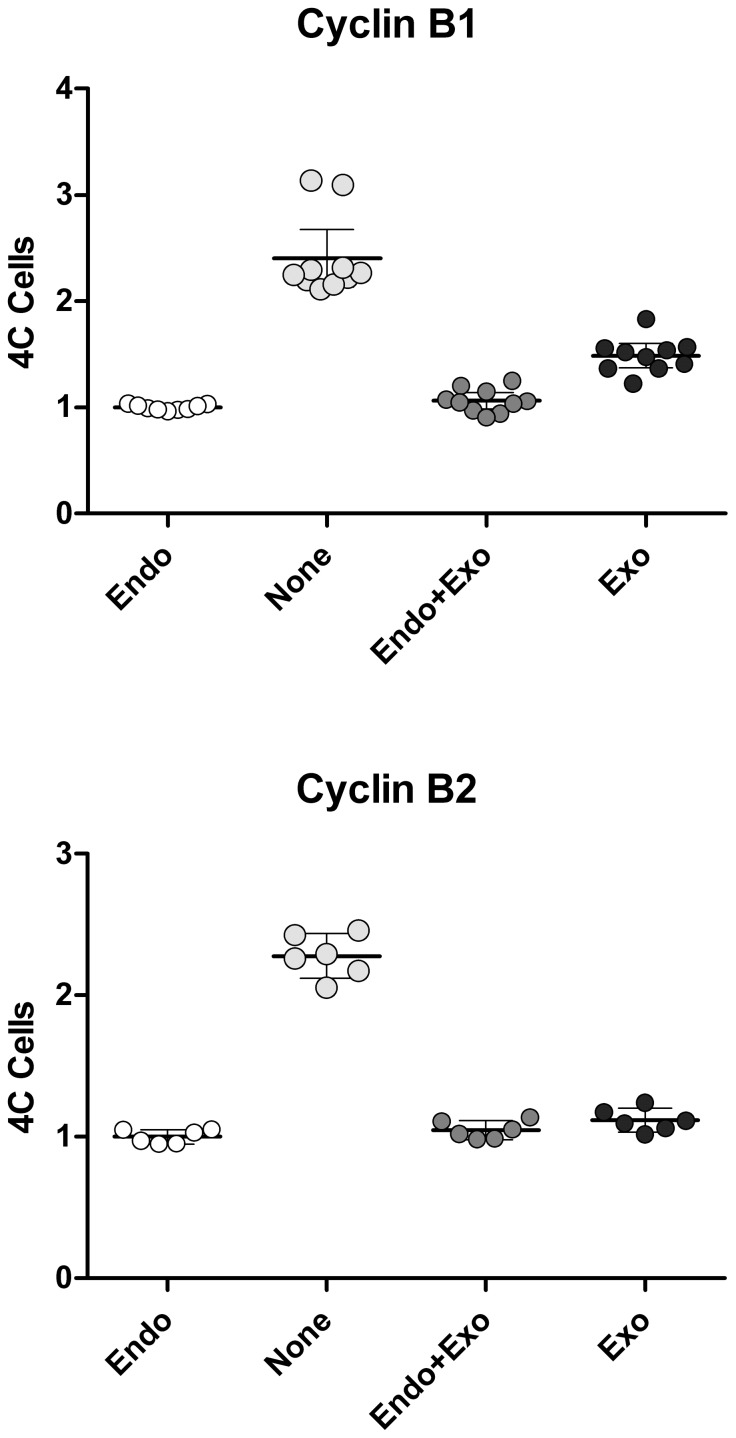
Single B cyclin-EGFP can rescue the G2 arrest of endogenous cyclin B1 and B2 co-depletion.Two clonal cell lines for each B cyclin and two independent experiments were performed as in Figure 8. The percentage of 4C cells in control cells (Endo) were normalized to 1. Co-depletion increases G2 cells by 2 to 3 times (None). Expression of B cyclin-EGFP in the presence of endogenous cyclins did not change G2 fractions (Endo+Exo). Expression of single B cyclin-EGFP in the presence of endogenous cyclin co-depletion restored G2 fractions close to normal cycling levels (Exo).